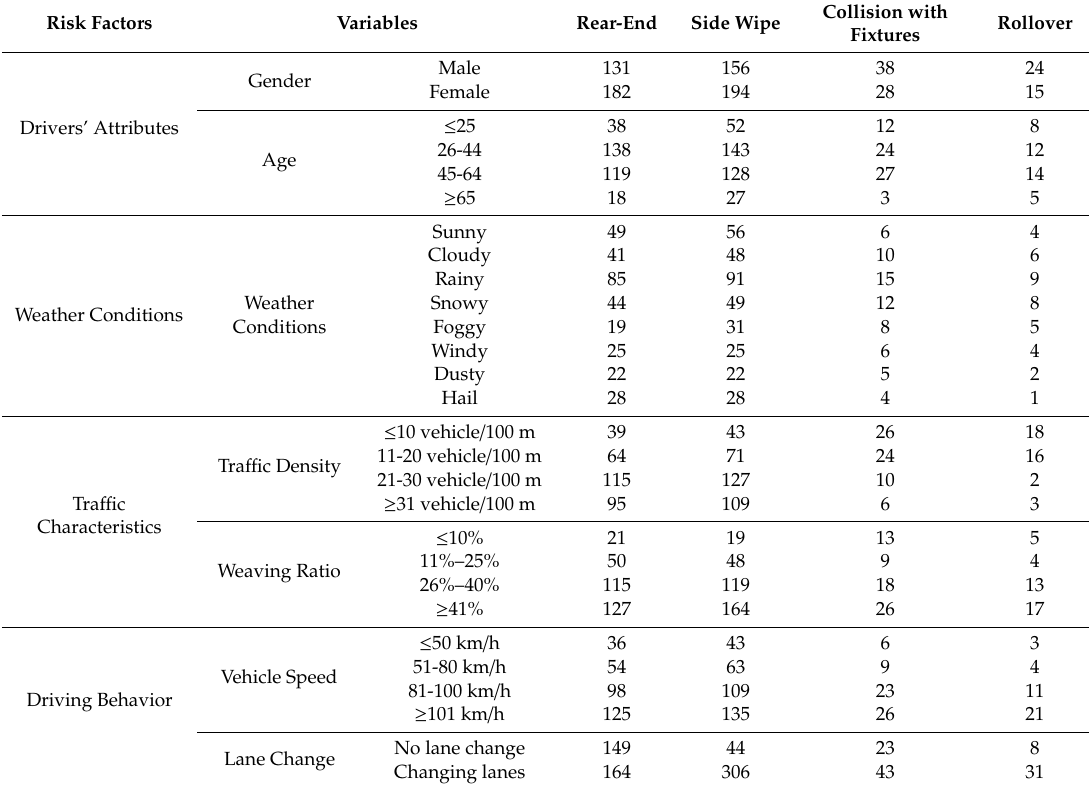
Table A1. Descriptive statistics of variables (number of tra ffi c